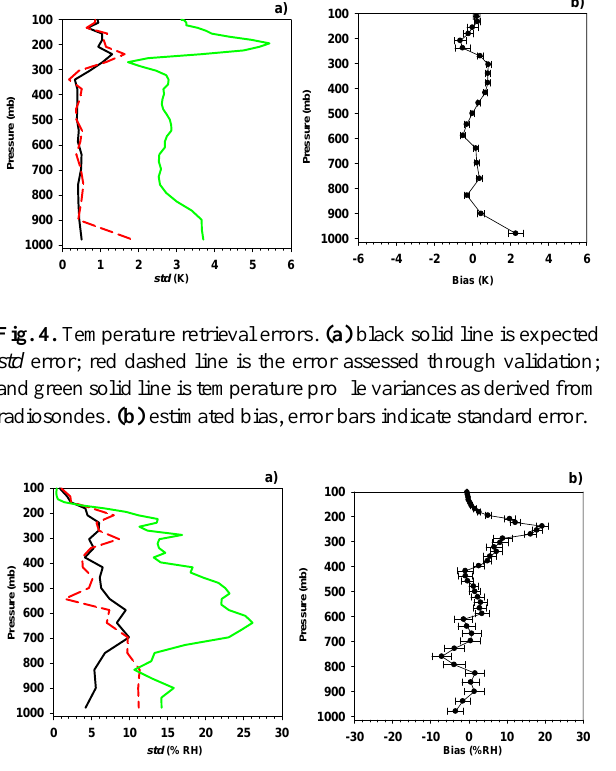
Fig. 5. Relative Humidity retrieval errors. (a) black solid line is expected std error; red dashed line is the error assessed through validation; and green solid line is temperature profile variances as derived from radiosondes. (b) estimated bias, error bars indicate standard